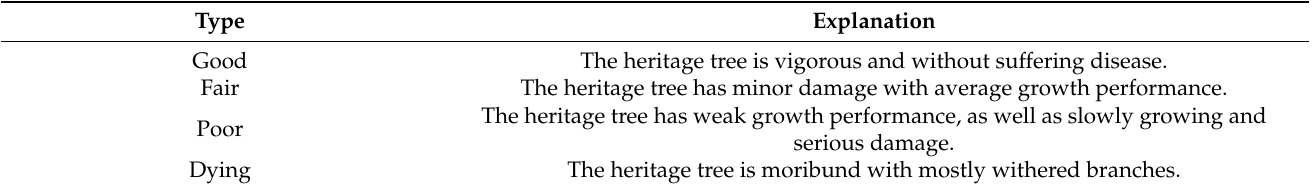
Table 2. Gradients division of growth status of heritage trees in Jiangsu Province, eastern